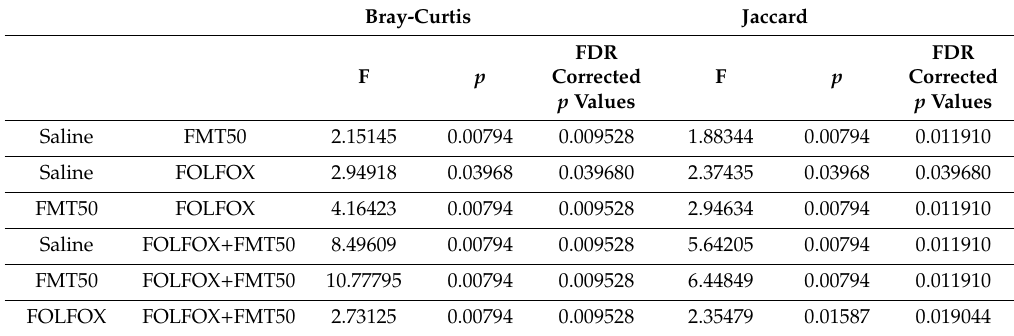
Table 3. p , F values and false discovery rate (FDR) correction from tests of Bray–Curtis and Jaccard similarity indices to evaluate the significance of FMT in changing the gut microbiota from the stool of subcutaneously injected colorectal cancer mice challenged with FOLFOX ( n = 5 for each group).